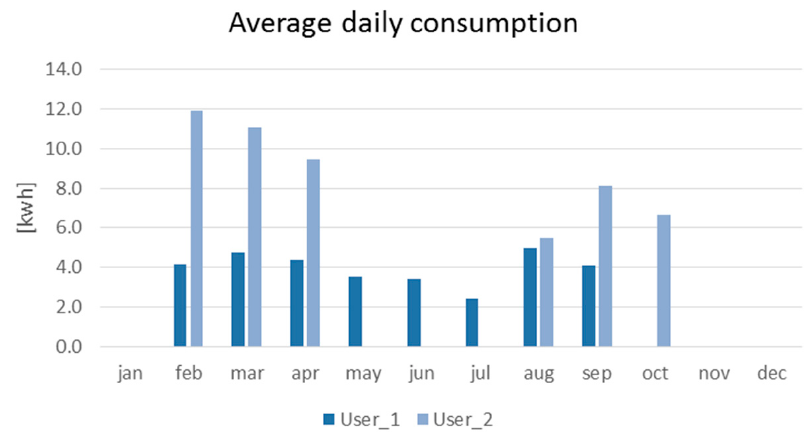
Figure 6. Monitored data.